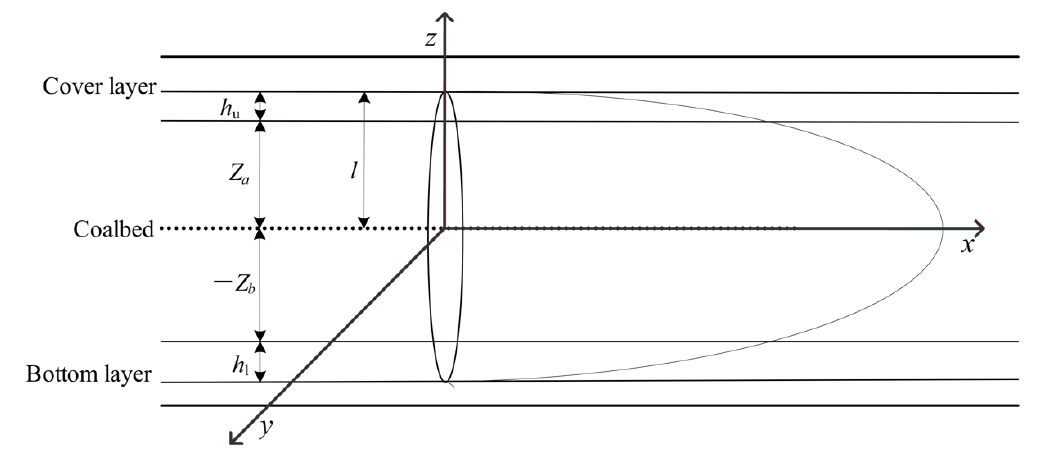
Figure 2. Schematic of vertical fracture propagation.